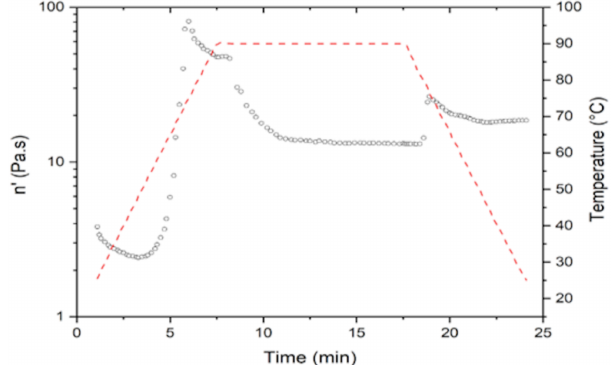
Figure 3. Viscoamilograms of extrusion modified starch.